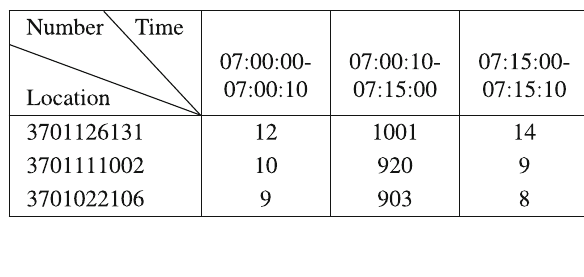
Table 1 Monitoring node N 1 maintains the records information